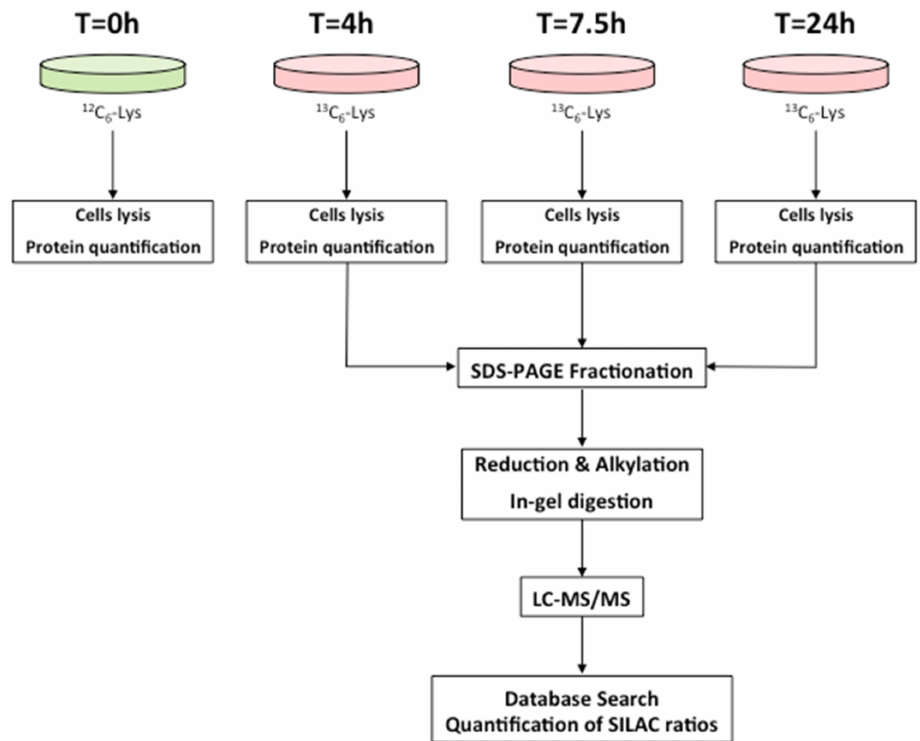
Figure 1. Proteomics workflow used to estimate turnover rates of individual proteins. Cells were grown in the SILAC heavy medium and collected at 4, 7.5, and 24 h. Following cell lysis and protein quantification, a fractionation step by SDS-PAGE was performed, and proteins were then digested and analyzed by LC-MS/MS as detailed in Section